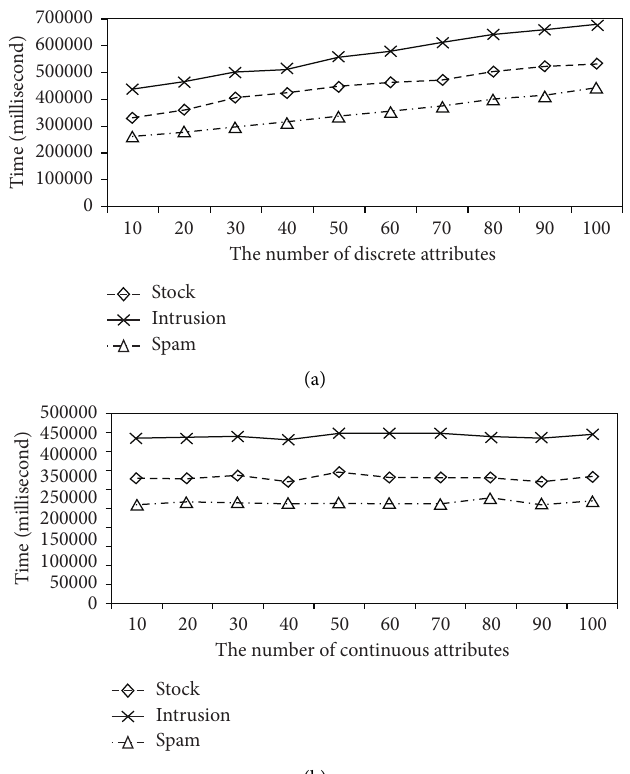
Figure 7: The impact of number of